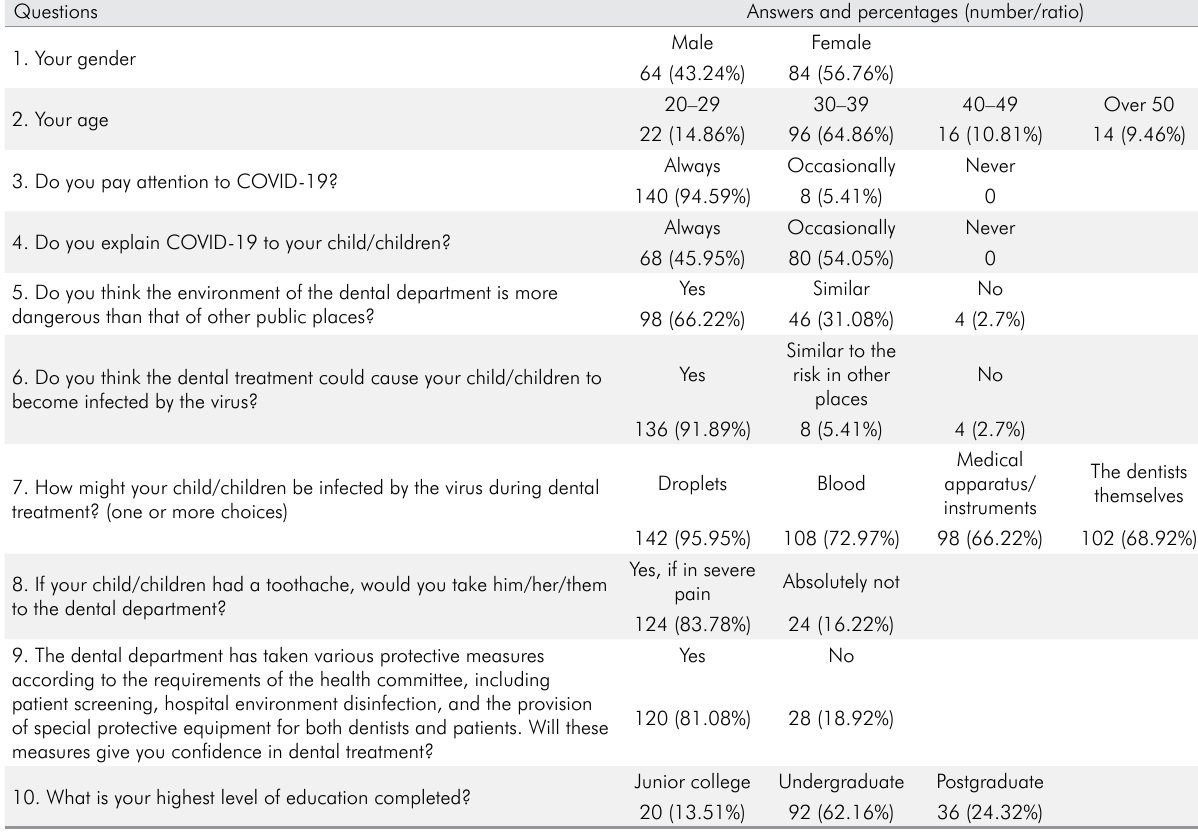
Table 1. Questions and percentage of answers recorded